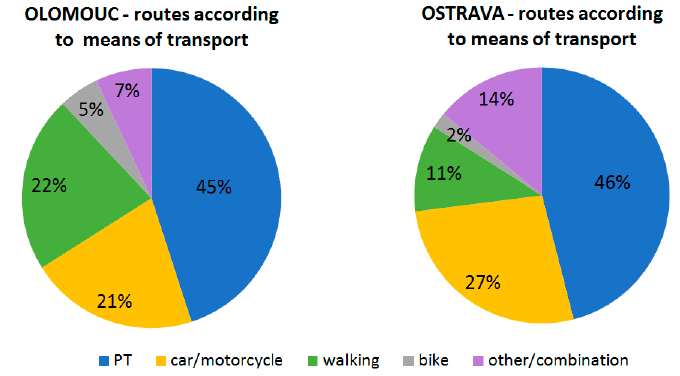
Figure 1. Structure of regularly used mode of transport to work and school in Olomouc and